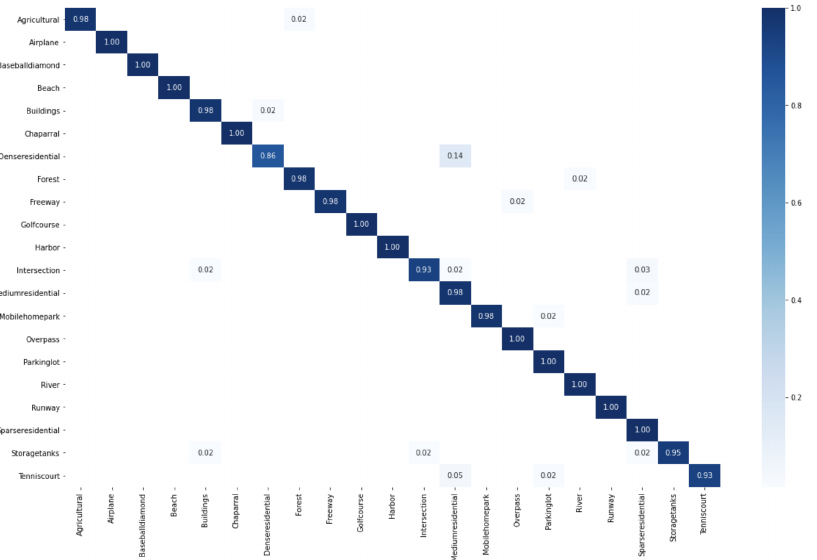
Figure 8. Confusion matrix of our method under the 50% training ratio and 50% of important features on the UC Merced data set.